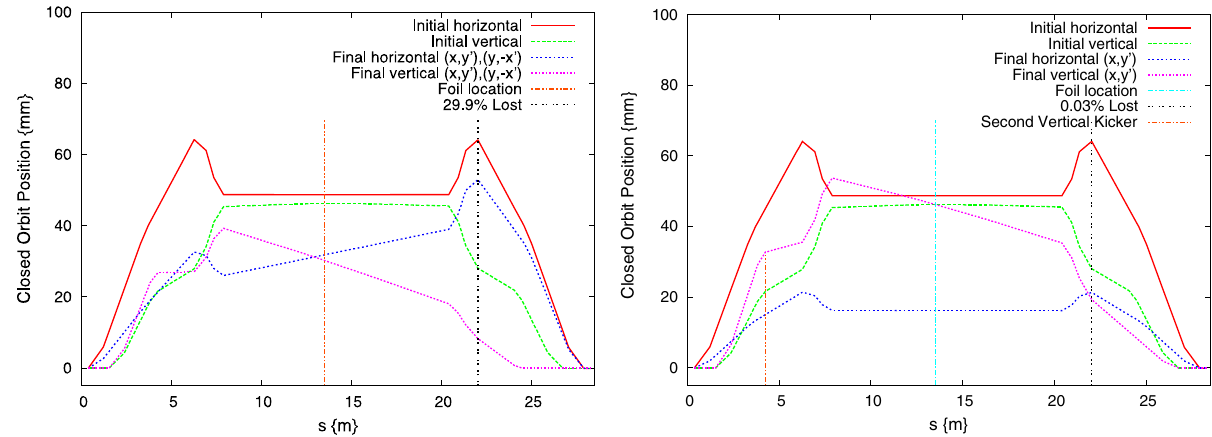
FIG. 6. (Left) Initial and final closed orbit offsets in the injection straight section for a painting scheme with comparable portions of x - y 0 and y - x 0 painting. Note that beam loss is nearly 30% due to scraping just after the downstream quadrupole doublet. (Right) Initial and final closed orbit offsets in the injection straight section for a painting scheme varying x - y 0 only. Now the beam loss is reduced by 3 orders of magnitude to 0.03%, still due to scraping after the downstream quadrupole